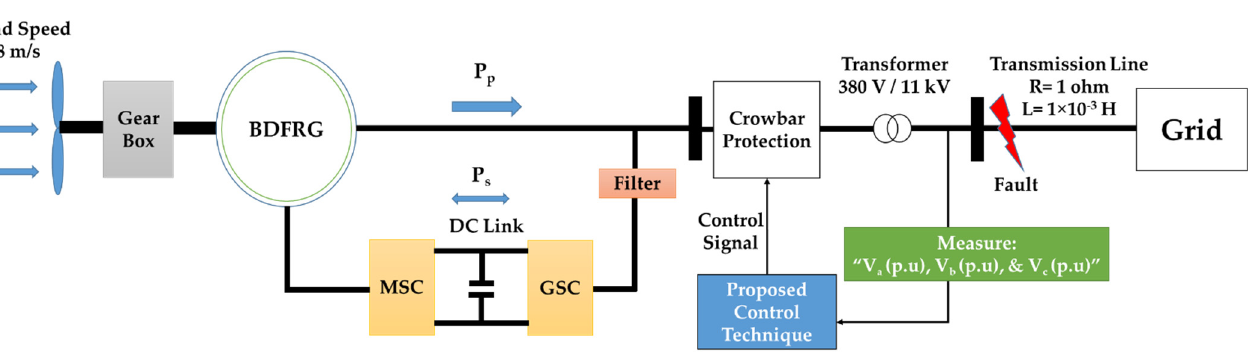
Figure 3. Flow chart of the proposed control for the crowbar.